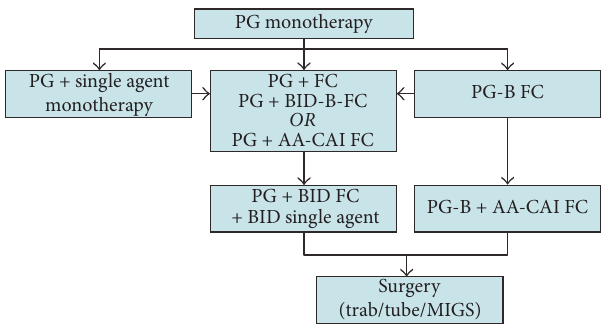
Figure 5: Glaucoma pharmaceutical management algorithm (SLT, MIGS, or other surgeries may be performed at any step of the algorithm). FC, fixed combination; BID single agent, dorzo- lamide, brinzolamide, and brimonidine; PG, prostaglandin ana- logue (latanoprost, travoprost, and bimatoprost); PG- 𝛽 B FC, prostaglandin + timolol (latanoprost + timolol, travoprost + tim- olol); BID- 𝛽 B FC, BID-dosed combination with timolol (dorzo- lamide + timolol, brinzolamide + timolol, brimonidine + timo- lol); AA-CAI F, 𝛼 agonist + CIA (brimonidine + brinzolamide); SLT, selective laser trabeculoplasty; MIGS, microinvasive glaucoma surgery. Patient and disease characteristics should be considered at all stages of algorithm and the therapy should be individualized according to patient needs (i.e., ability to tolerate any component of the therapy). In addition, at all stages of the treatment algorithm it is imperative to monitor for adverse effects as well as disease progression